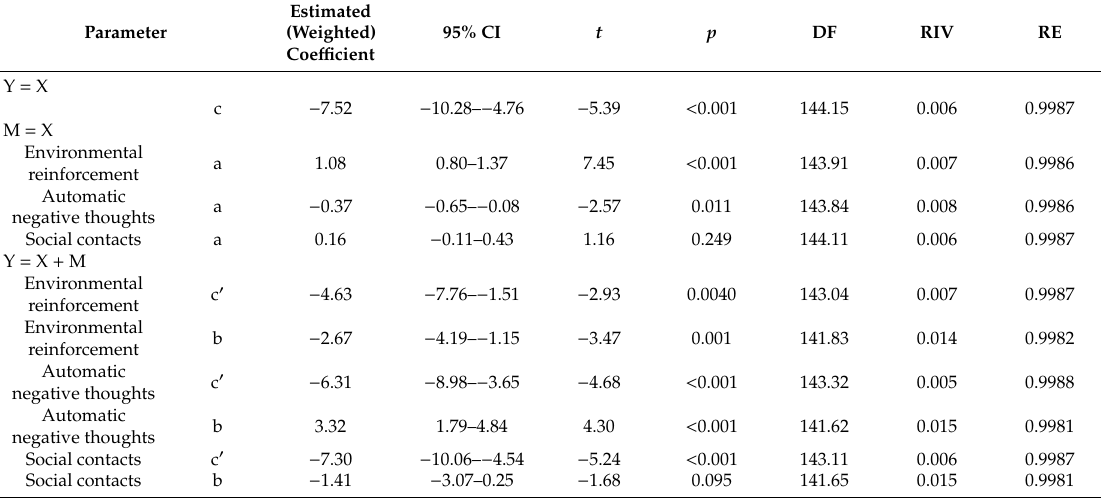
Figure 5. Plot of the effect of the interaction between relationship and group on the change in depressive symptoms between the pre-intervention time point and 12-month follow-up. Table 5. Analysis of mediation for positive environmental reinforcement, negative automatic thoughts, and social contacts at the post-intervention time point for the CBCC